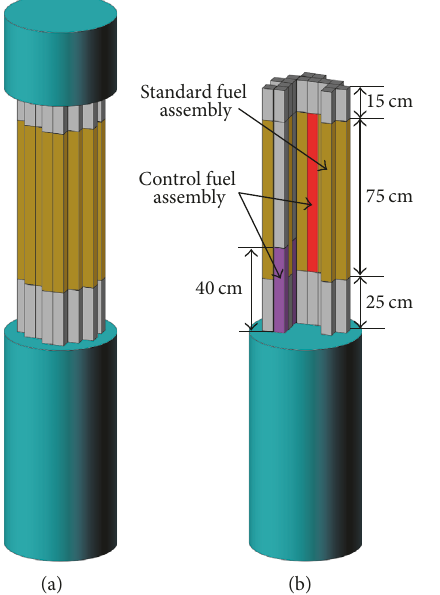
Figure 3: Geometry of HFRR fuel assemblies: (a) overview of the geometry model; (b) detailed structure of the virtual fuel assemblies.